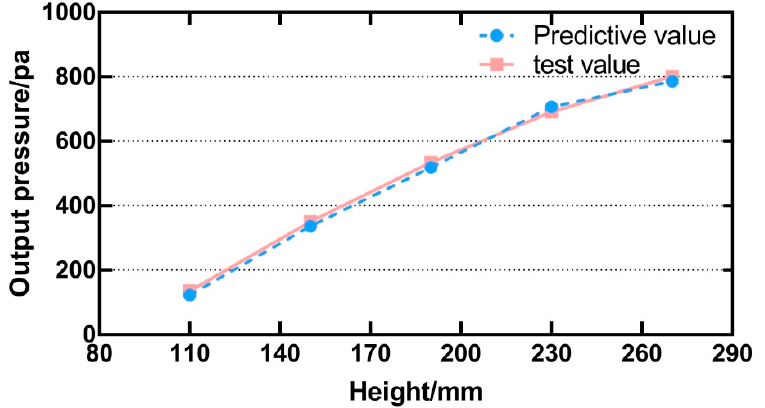
Figure 14. Test values and predicted values at different heights on the vertical line where the centre point of the array is located.